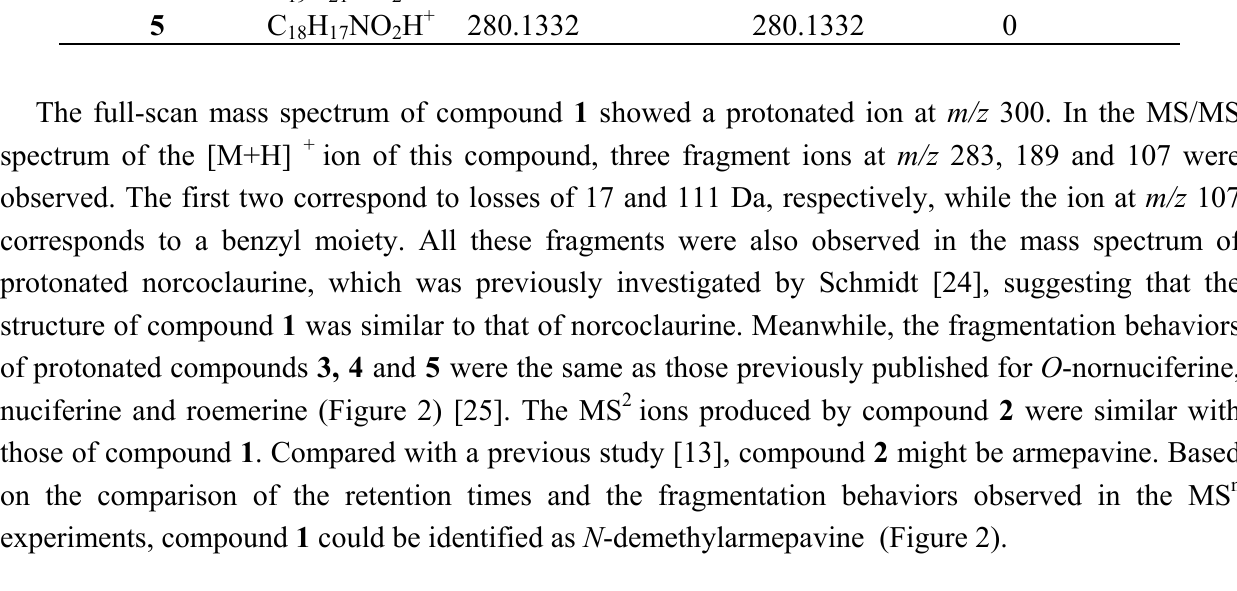
Figure 2. Chemical structures of target alkaloids in this